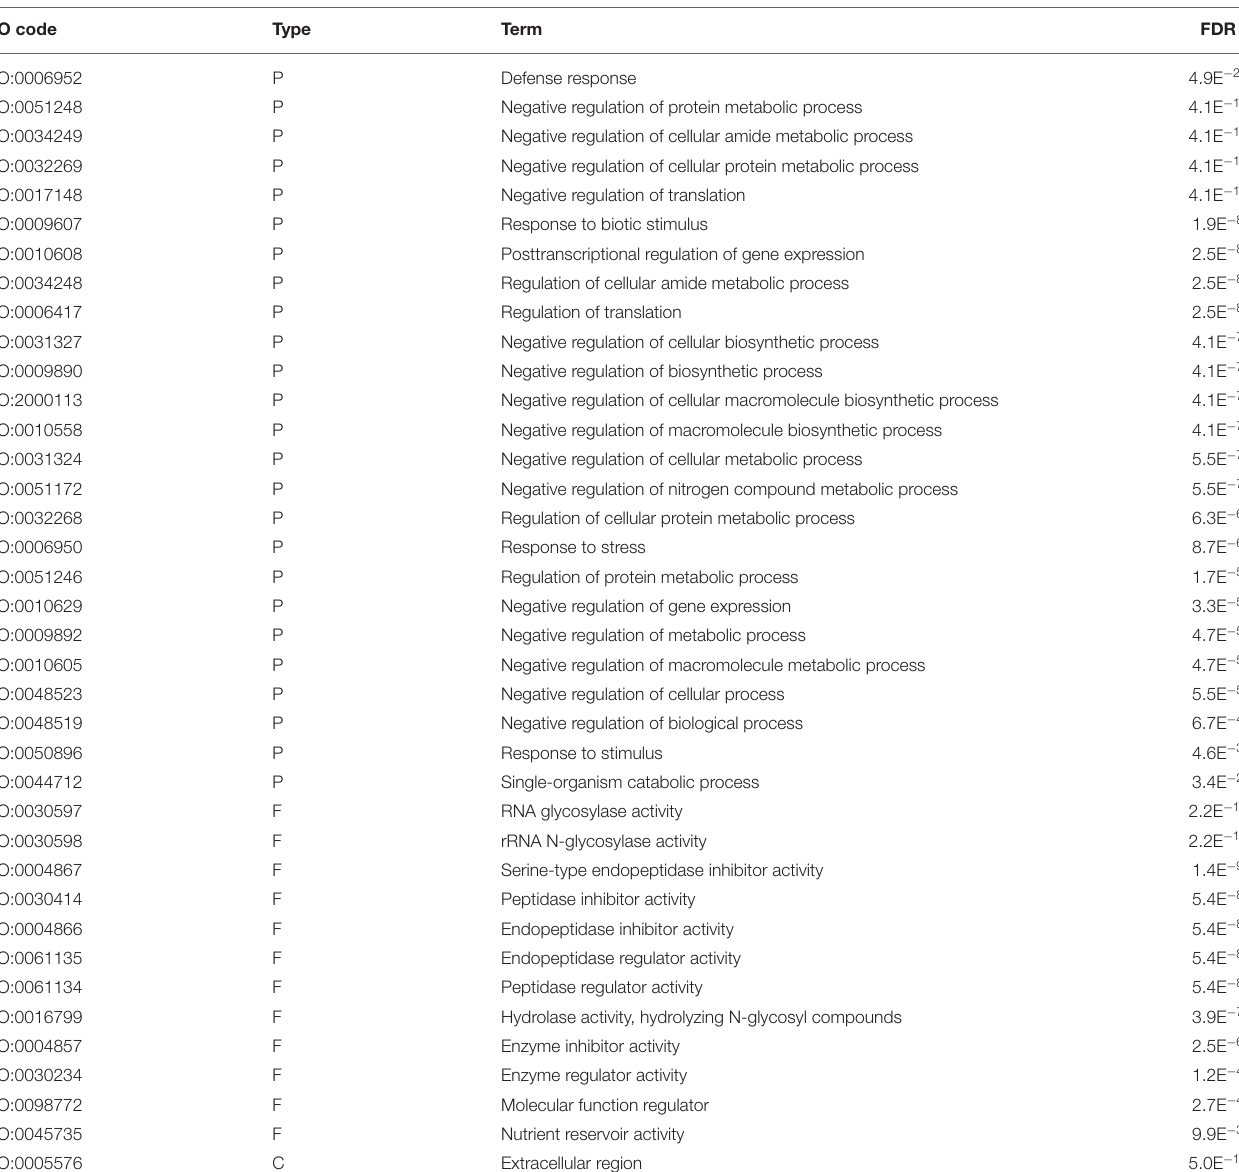
TABLE 6 | Gene Ontology (GO) terms of “Norman” vs. “CDC Kendall” contrast identified in the additive, interactive generalized linear model. GO code Type